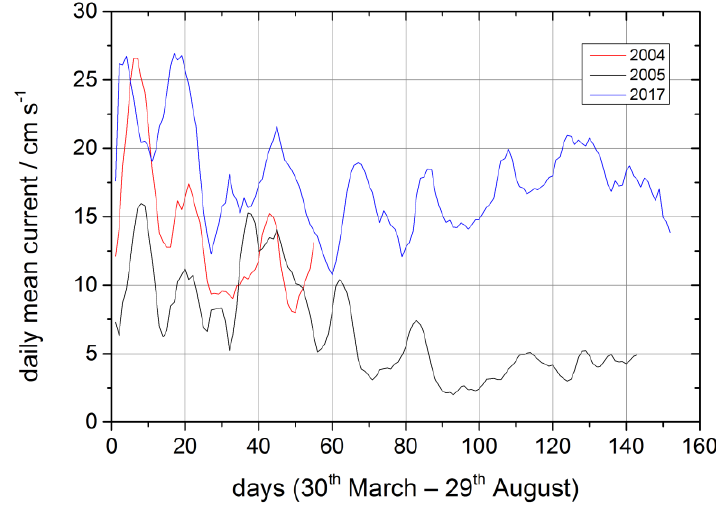
Figure 14. Comparison of daily mean values of currents magnitude at the selected cell.